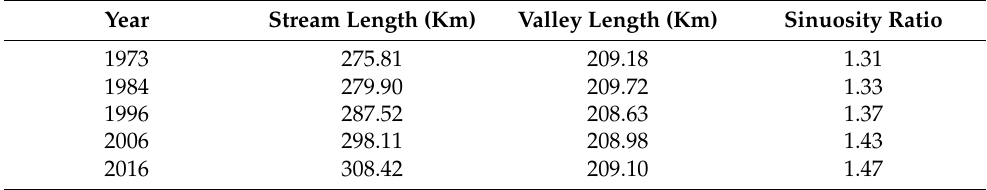
Table 2. Measurement of Sinuosity Ratio of the Ganges-Padma River during 1973–2016. Year Stream Length (Km) Valley Length (Km) Sinuosity Ratio 1973